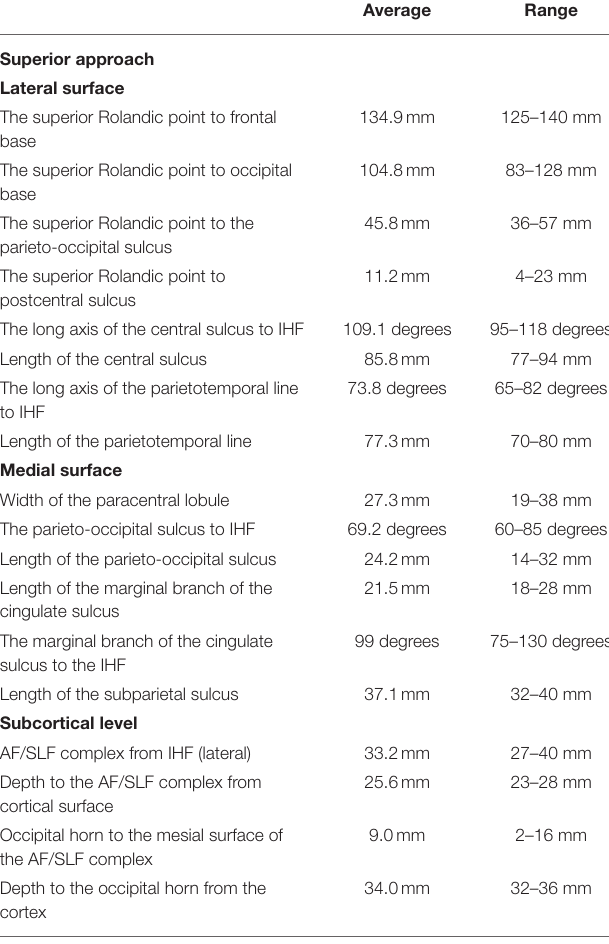
TABLE 2 | Measurements related to the superior